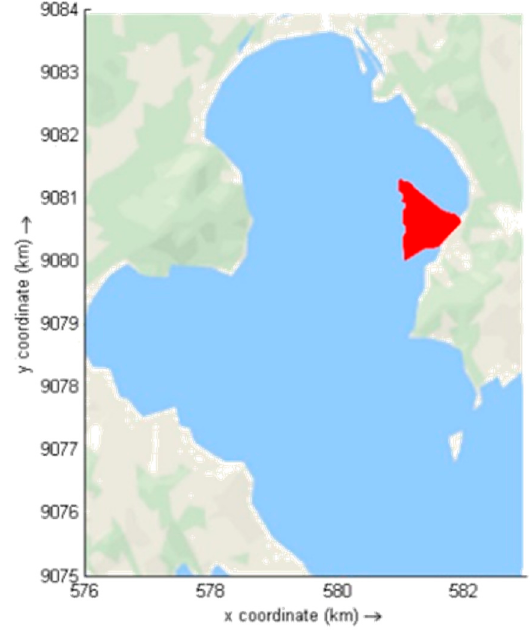
ff shore Aquaculture (red Figure 13. Suitable Area for Offshore Aquaculture (red area). Figure 13. Suitable Area for O